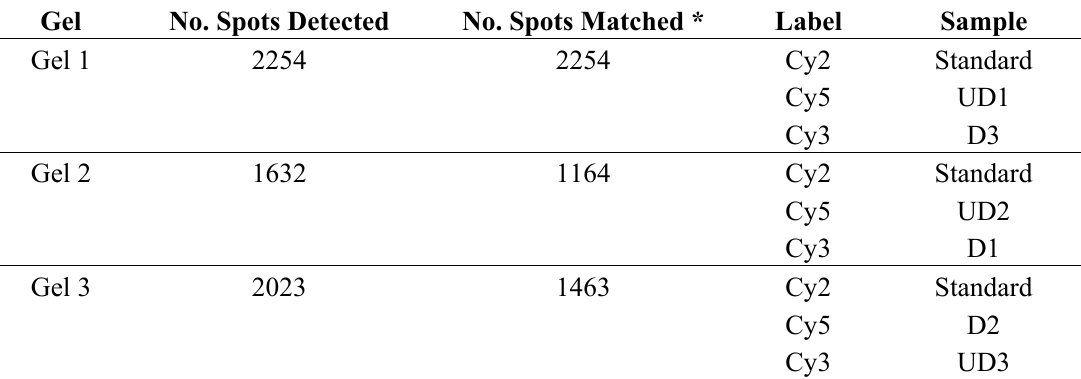
Table 1. Number of protein spots detected in the three replicates of undifferentiated and differentiated Caco-2